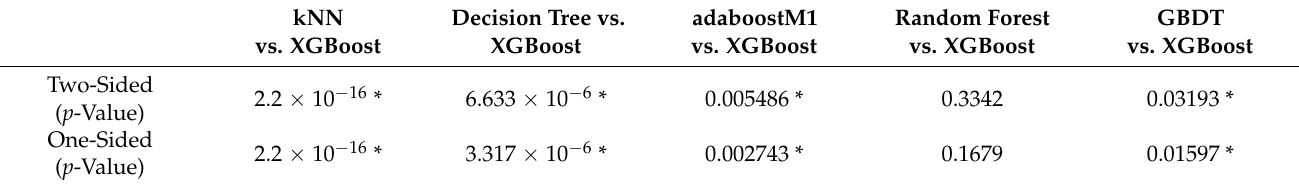
Figure 4. These ROC curves compare the discriminative performances of individual features versus combinations of features. Table 5. Kolmogorov-Smirnov predictive accuracy test (13 features).